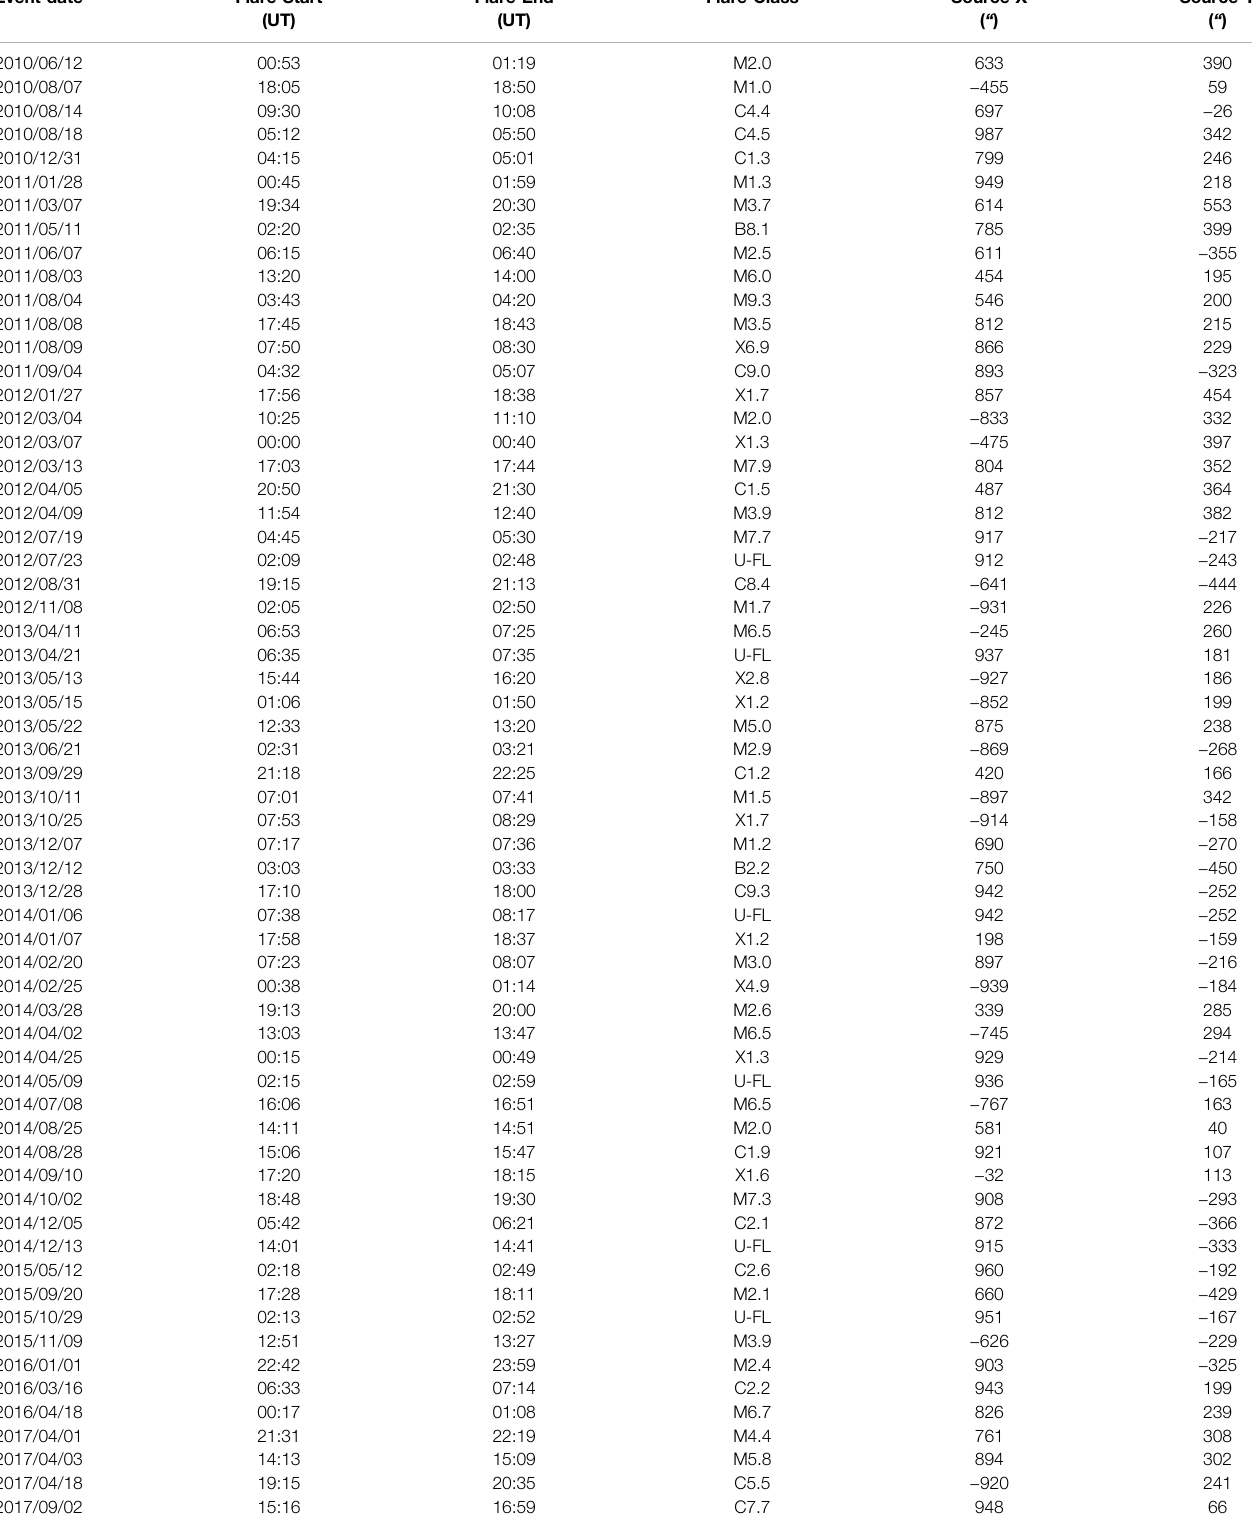
TABLE 1 | Events in this